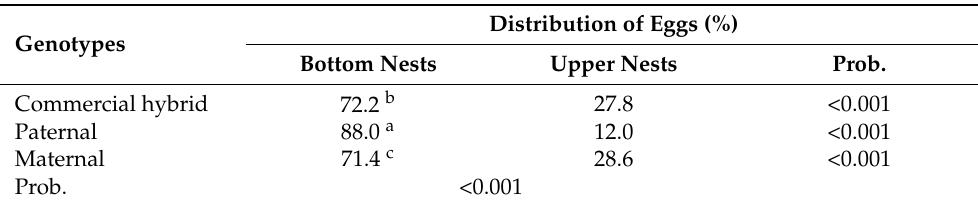
Table 2. The total ratios of eggs laid in the lower and upper nests during the 12 production months in percentages (%).